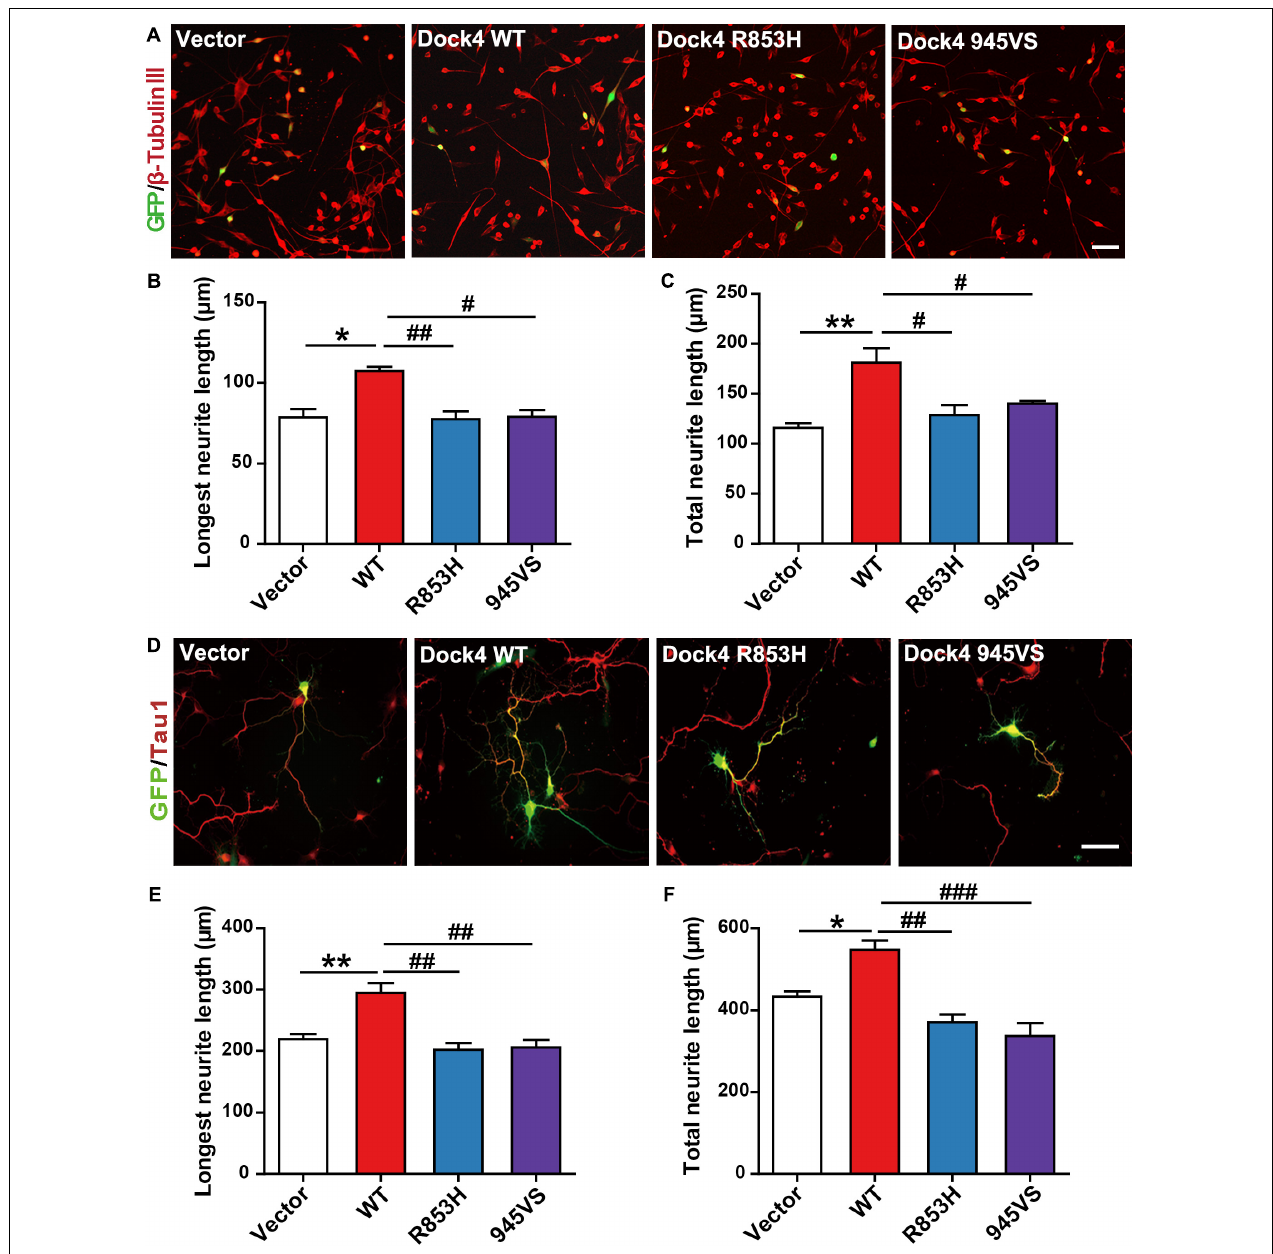
FIGURE 5 | Dock4-R853H and 945VS lack neurite outgrowth abilities. (A) Dock4 mutants could not promote RA-induced neurite outgrowth in Neuro-2a cells. Neuro-2a cells were transfected with plasmids expressing Dock4-WT, Dock4-R853H, Dock4-945VS or Vector, followed by treatment with RA (15 µ M) for 48 h. Cells were immunostained using β -tubulin III antibody for visualization of neurites, and transfected cells were indicated by GFP. Scale bar, 100 µ m. (B,C) Average length of the longest neurite and average length of total neurites were measured. ∗ P < 0.05, ∗∗ P < 0.01, # P < 0.05, ## P < 0.01, one-way ANOVA. At least 40 cells/group were analyzed in each experiment. (D) Dock4 mutants could not promote neurite outgrowth in hippocampal neurons. Dissociated E18 hippocampal neurons were transfected with plasmids expressing Dock4-WT, Dock4-R853H, Dock4-945VS or Vector, cultured for 3 days. Axon-like process were immunostained with Tau1 (red) antibody, and transfected cells were indicated by GFP. Scale bar, 50 µ m. (E,F) Average length of the longest neurite and average length of total neurites were measured. ∗ P < 0.05, ∗∗ P < 0.01, # P < 0.05, ## P < 0.01, ### P < 0.001, one-way ANOVA. At least 40 cells/group were analyzed in each